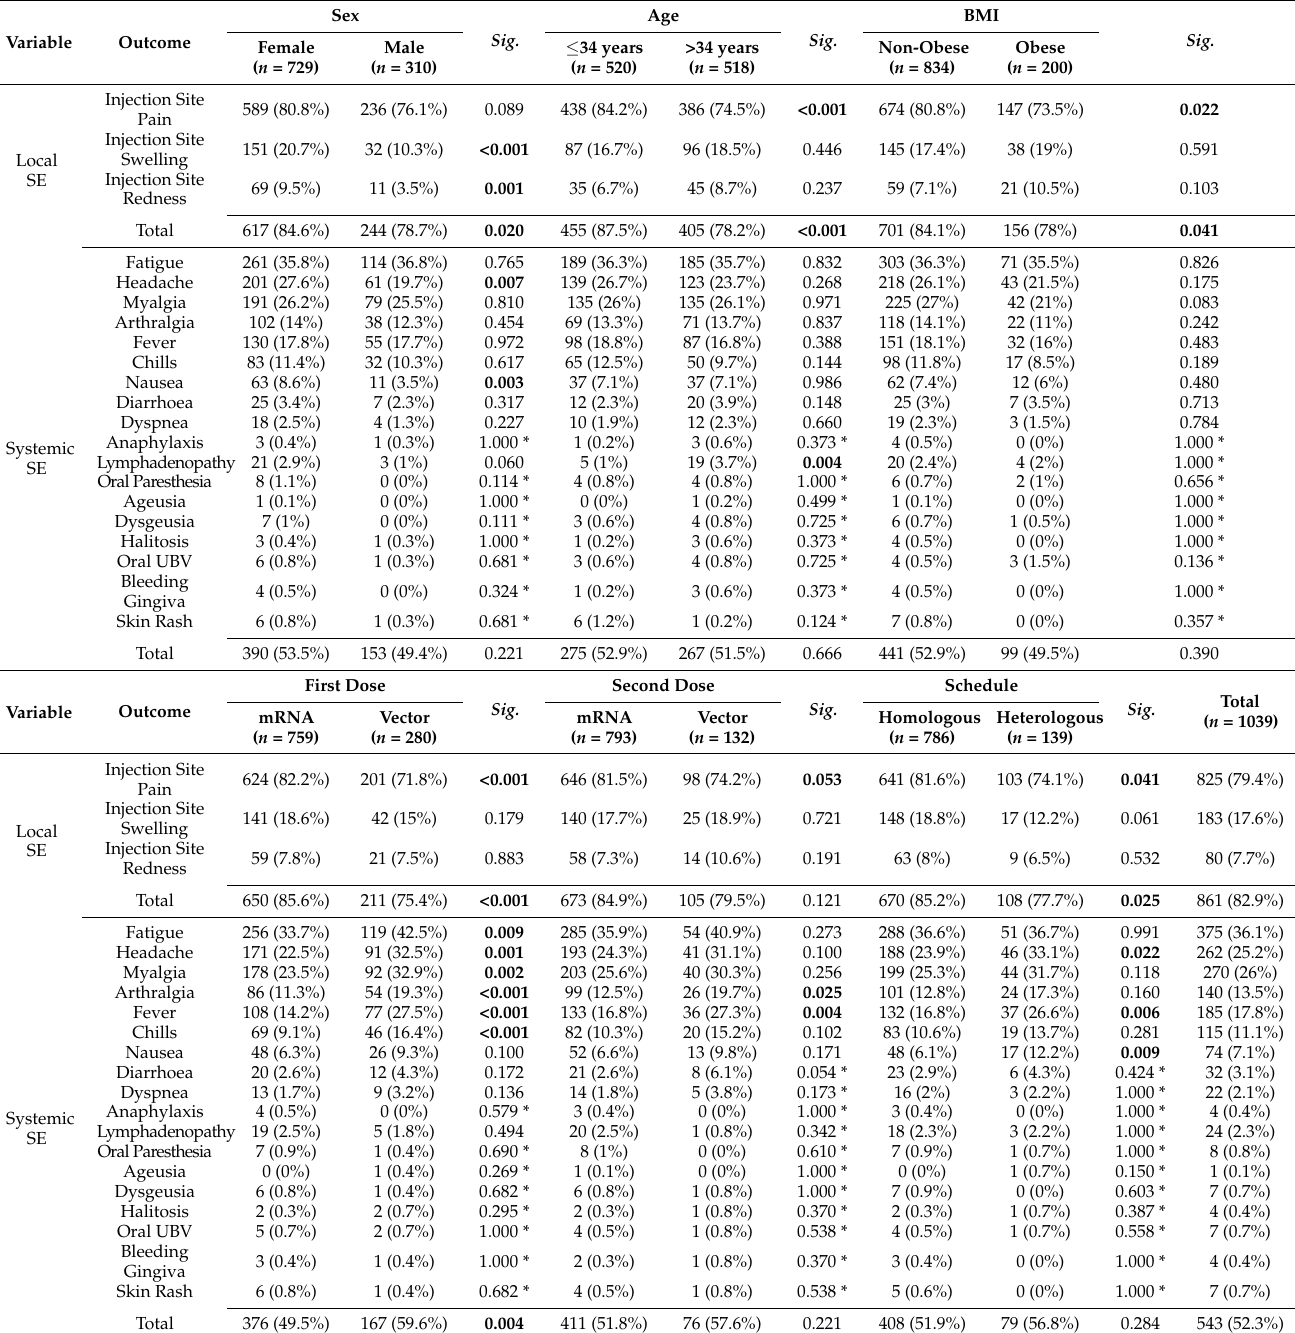
Table 2. Prevalence of COVID-19 Side Effects Experienced by Saudi Healthcare Workers Responding to CoVaST-SA, ( n =